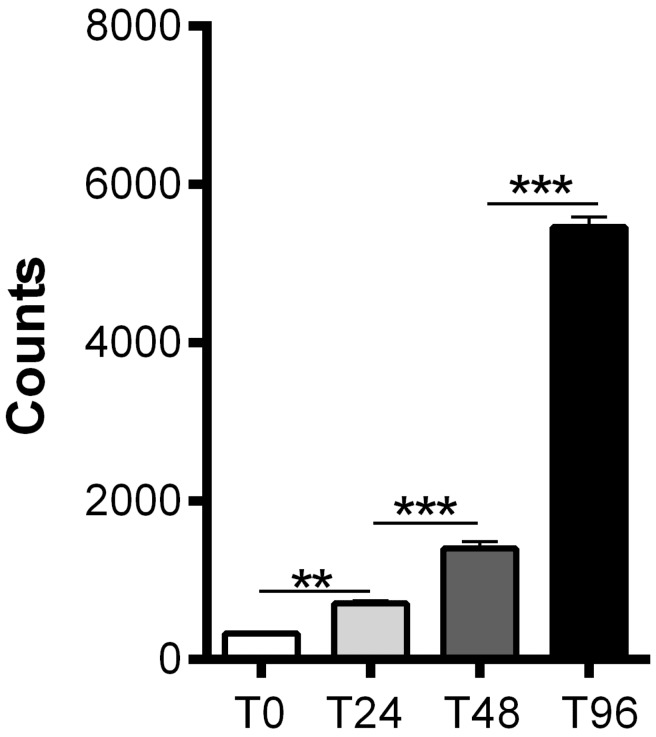

In vitro proliferation of hMSCs.Proliferating capacity of hMSCs in vitro. 1000 hMSCs were plated (T0) and proliferation was assessed at 4(T0), 24(T24), 48(T48) and 96(T96) hours after plating the MSCs by adding 3H-thymidine to the culture and measuring 3H-thymidine uptake 16 hours later. Data represent mean ± SEM. ** p<0.01; *** p<0.001 by ANOVA and Bonferroni post-hoc test. (n = 10 wells for each condition).